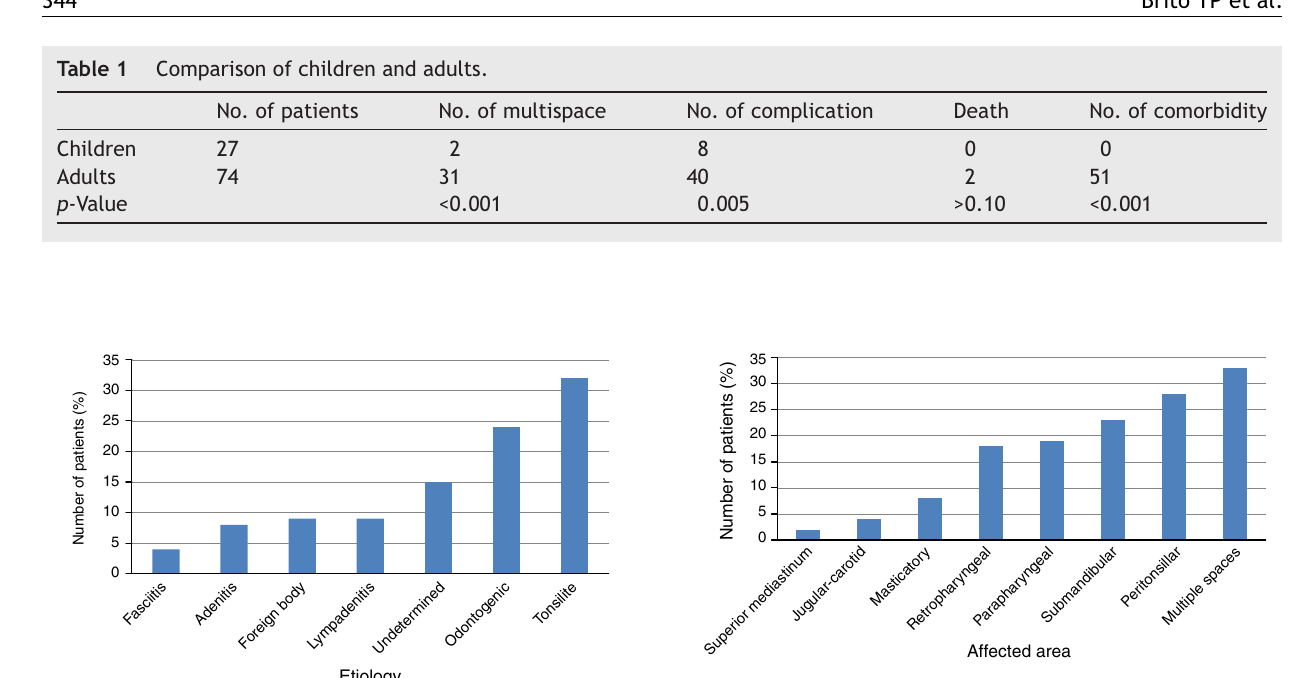
Figure 3 Extent of infeccion by deep cervical abscesses.